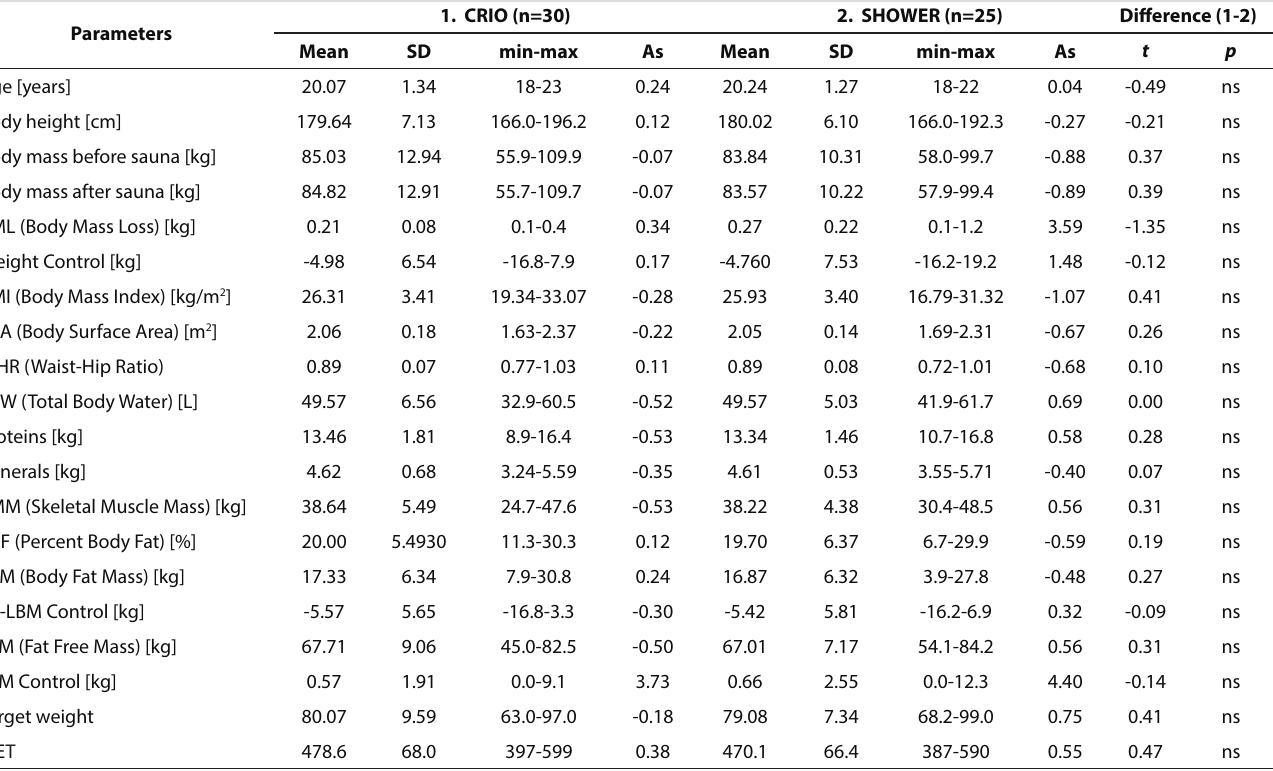
TABLE 1. Descriptive statistics of the studied anthropometric and body composition parameters in (CRIO) and (SHOWER) groups